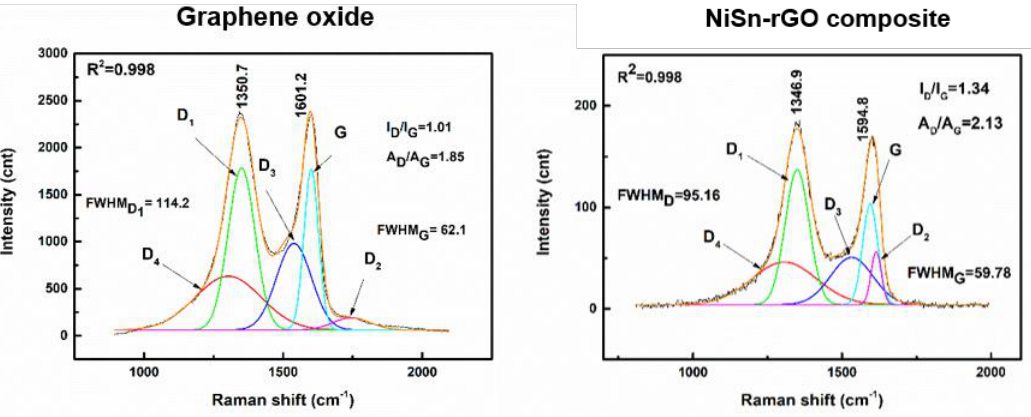
Figure 9. Raman spectra of: ( top ) graphene oxide and ( bottom ) the composite NiSn-rGO-P3.3.